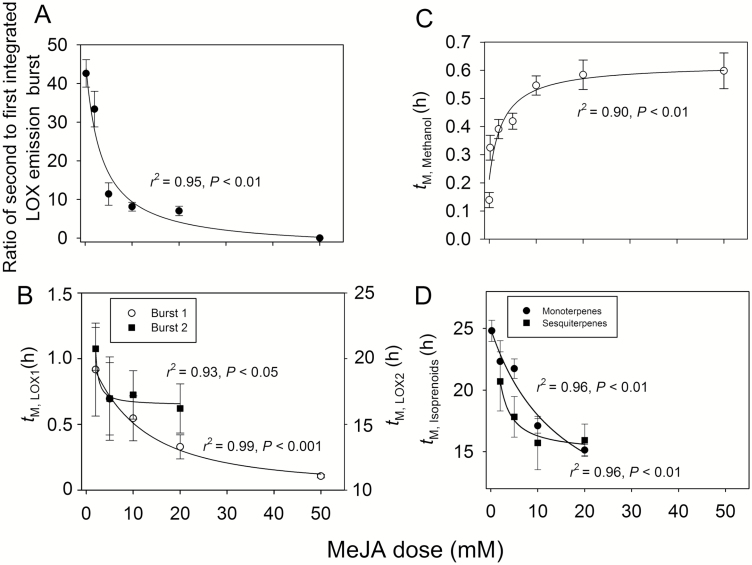
The ratio of the second to the first integrated LOX emission burst (ITLOX2/ITLOX2, A), and the times to the maxima of the first (tM,LOX1) and second (tM,LOX2) LOX emission bursts (B), emission burst of methanol (C) and the times to the maxima of monoterpene (tM,monoterpene) and sesquiterpene (tM,sesquiterpene) emission bursts (D) in relation to MeJA dose in leaves of C. sativus (see Fig. 2 for the sample responses and definition of the characteristics). MeJA treatments are as in Fig. 1 and data coverage is as in Fig. 3. In all cases, the data were fitted by hyperbolic regressions. For ITLOX2/ITLOX2 in (A), y=162/(3.27+x)–2.83, r2=0.95, P<0.01; for tM,LOX1 in (B), y=14.1/(11.7+x)–0.12, r2=0.99, P<0.001; for tM,LOX2 in (B), y=9.69/(0.0027+x)+15.7, r2=0.93, P<0.01; for tM,methanol in (C), y=0.41x/(2.90+x)+0.21; for tM,monoterpene in (D), y=281/(15.7+x)+7.03, r2=0.96, P<0.01; for tM,sesquiterpene in (D), y=14.6/(0.50+x)+14.9, r2=0.96, P<0.01. Three replicate treatments at each MeJA application concentration were carried out.